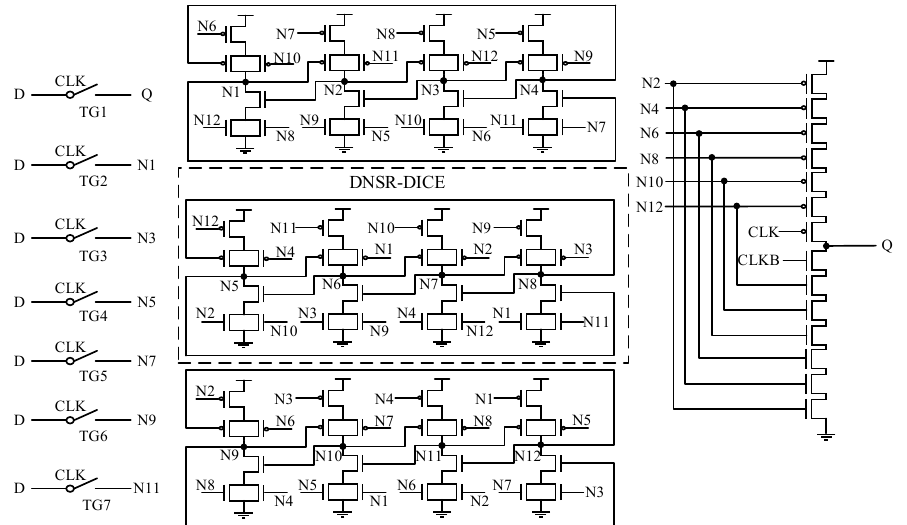
Figure 9. Proposed HLTNURL latch design.